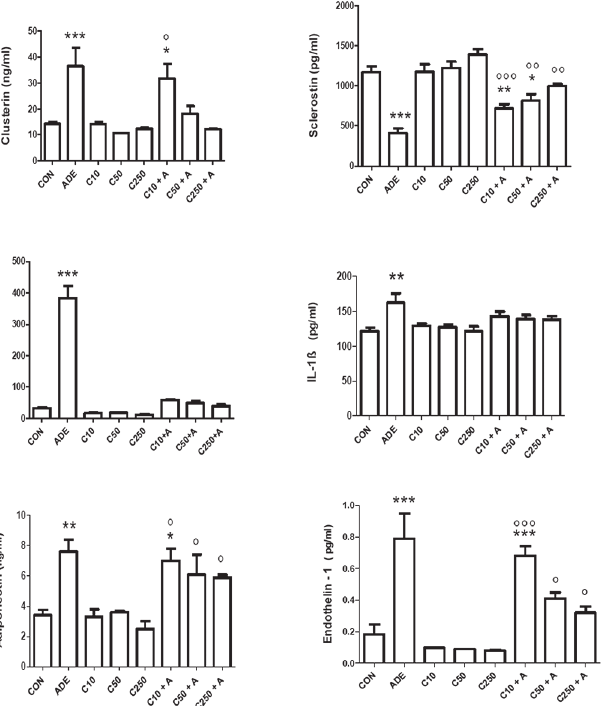
Fig 5. Effect of chrysin treatment on plasma concentrations of the cytokines tumor necrosis factor alpha (TNF α ), sclerostin adiponectin, interleukin – one beta (IL-1 β ) and endothelin in control rats and rats treated either singly or concomitantly with either adenine (ADE) or chrysin (C) at doses of 10, 50 or 250 mg/kg. Each column and vertical bar is a mean ± SEM (n = 6).